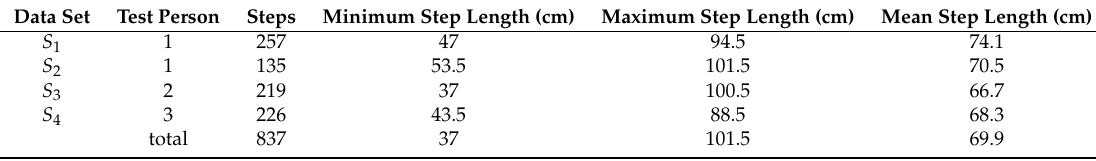
Figure 4. Method to determine ground truth for step lengths. Table 1. Properties of gathered steps and corresponding step